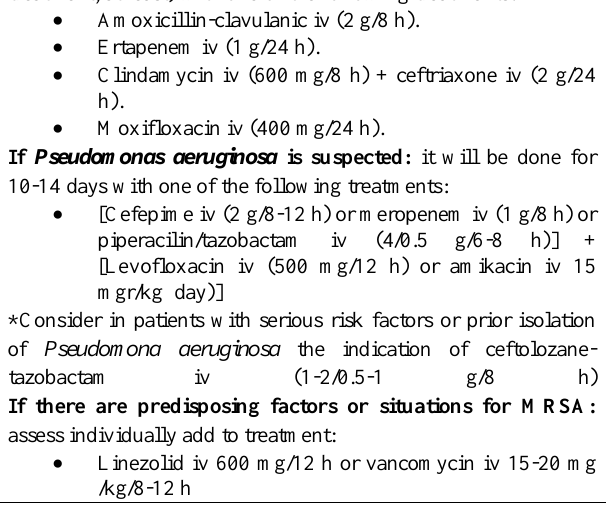
Table 11: Recommendations for antimicrobial treatment in CAP in special situations. CAP: Community acquired pneumonia; PSI: Pneumonia Severity Index; po: orally; iv: intravenous; h: